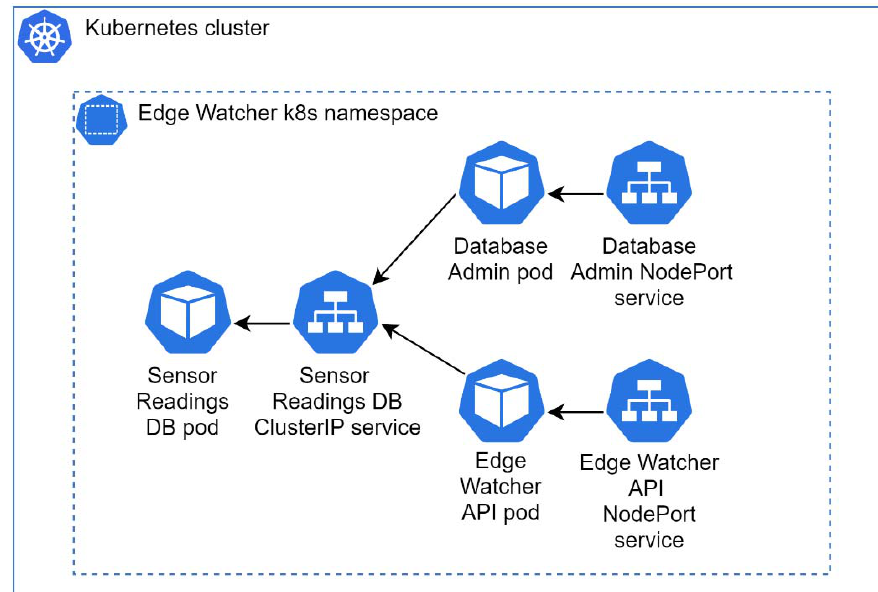
Figure 6. Kubernetes deployment architecture.